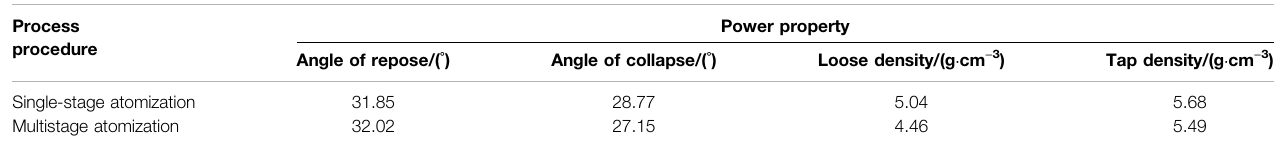
Process procedure Single-stage